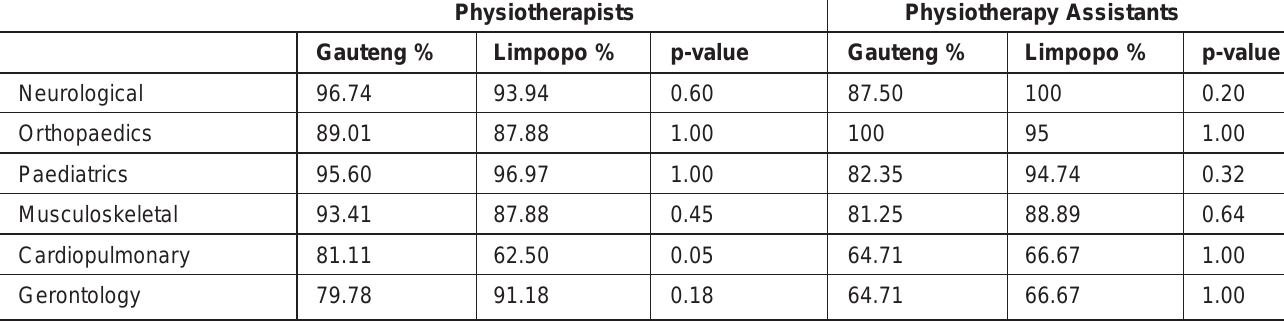
Table 5: Curative services